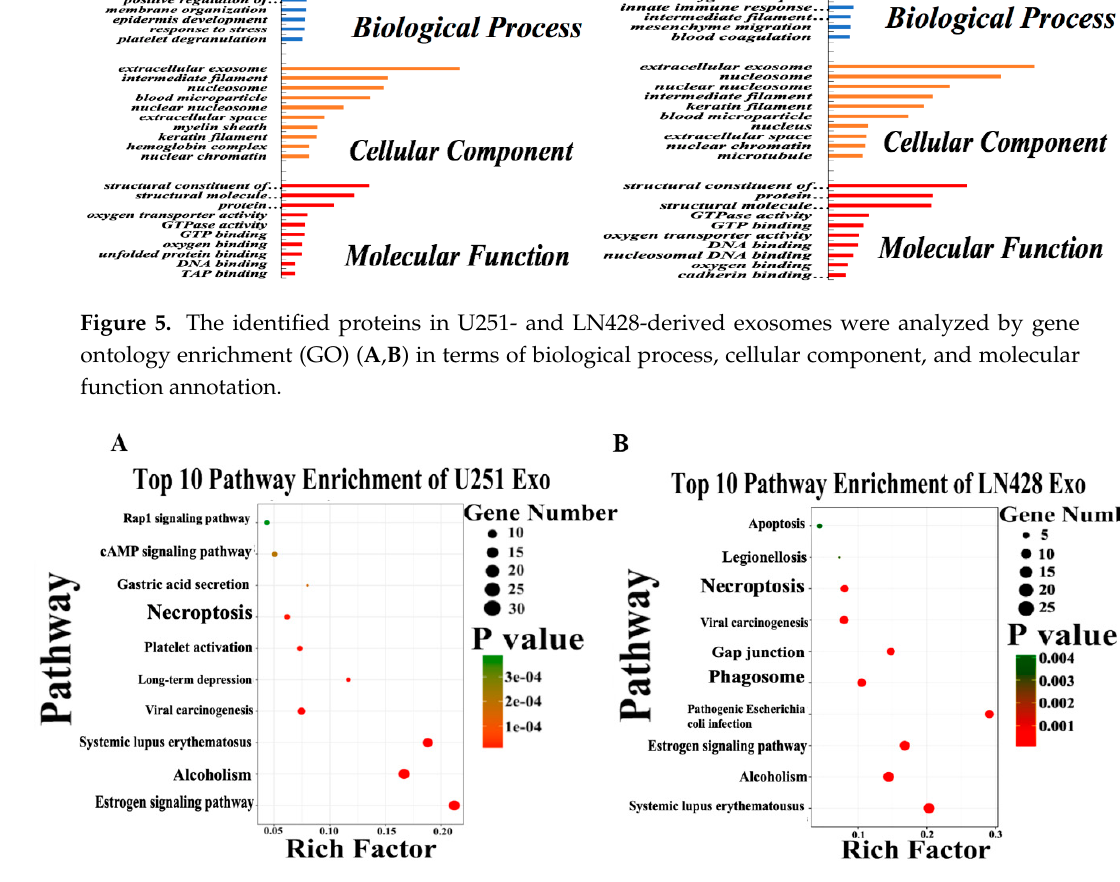
Figure 6. The top 10 pathway enrichment of differentially expressed exosome protein in U251 ( A ) and LN428 ( B ) cells were analyzed by Kyoto Encyclopedia of Genes and Genomes (KEGG) pathway.